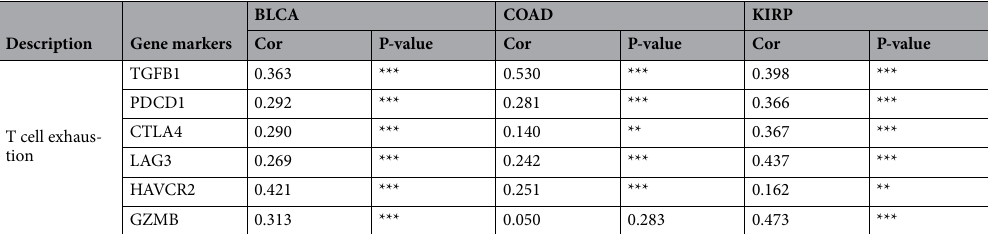
Table 1. Correlation analysis between PDLIM2 and relate genes and markers of immune cells of TCGA dataset by R (3.6.3 version; The R Project for Statistical Computing, Vienna, Austria) (the P values are